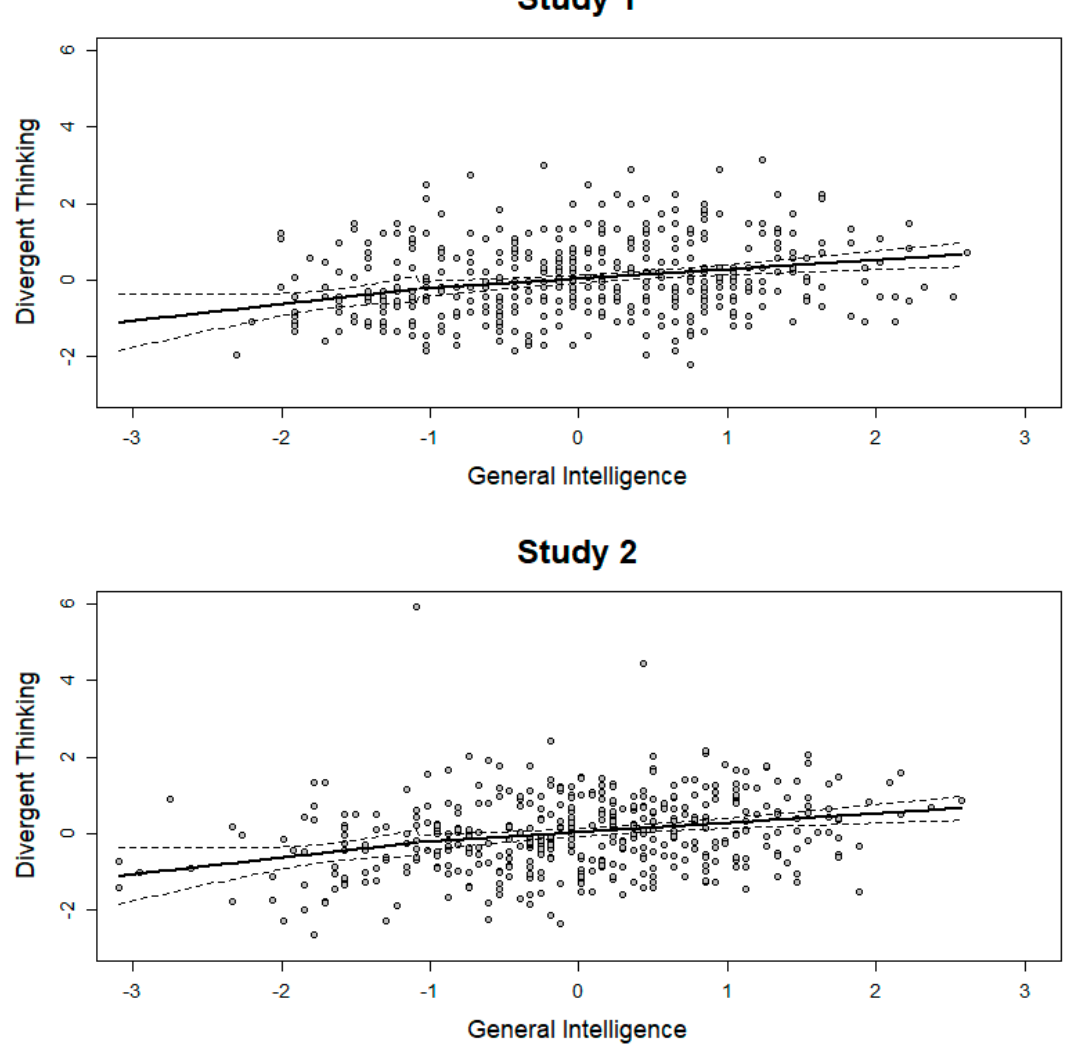
Figure 4. Segmented regression analysis. The breakpoint for the relation between general intelligence and divergent thinking. The dotted line represents the 95% confidence interval.